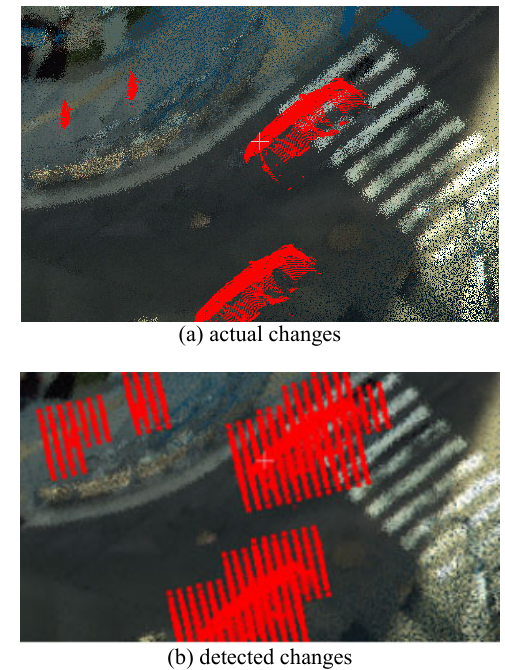
Figure 6 . Example of Change Detection (MMS